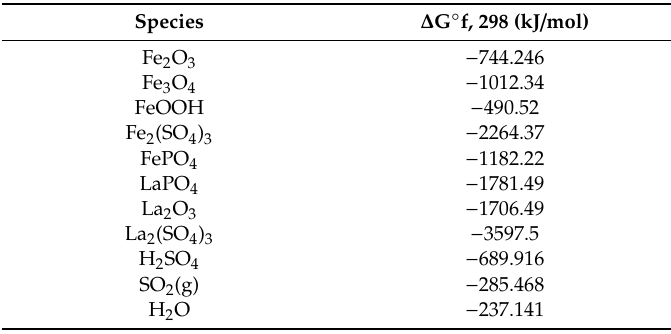
Table 1. Thermodynamic data—HSC Chemistry 7.15 database.